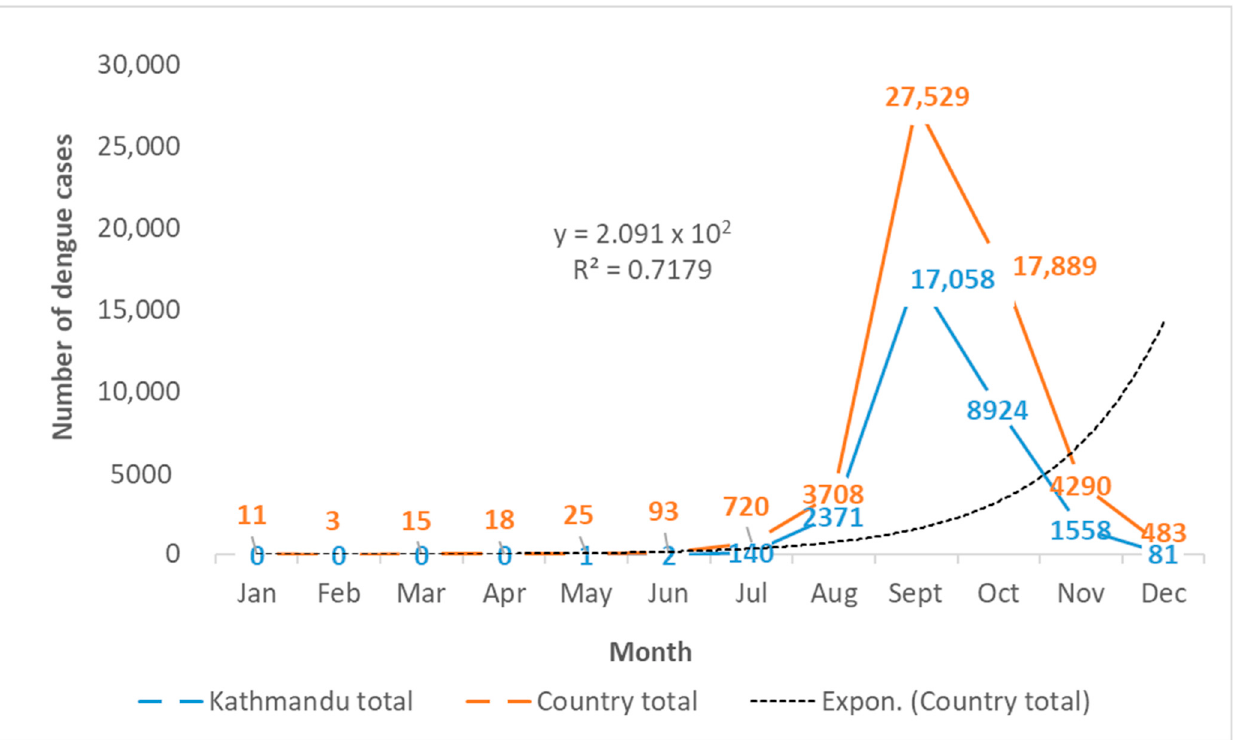
Figure 3. Temporal trend of dengue cases during the 2022 epidemic in Kathmandu ( n = 30,135) and Nepal ( n = 54,784). The dotted line is the trend line based on an exponential model of the country’s total dengue cases ( n = 54,784). Data source: EDCD, Nepal [22].